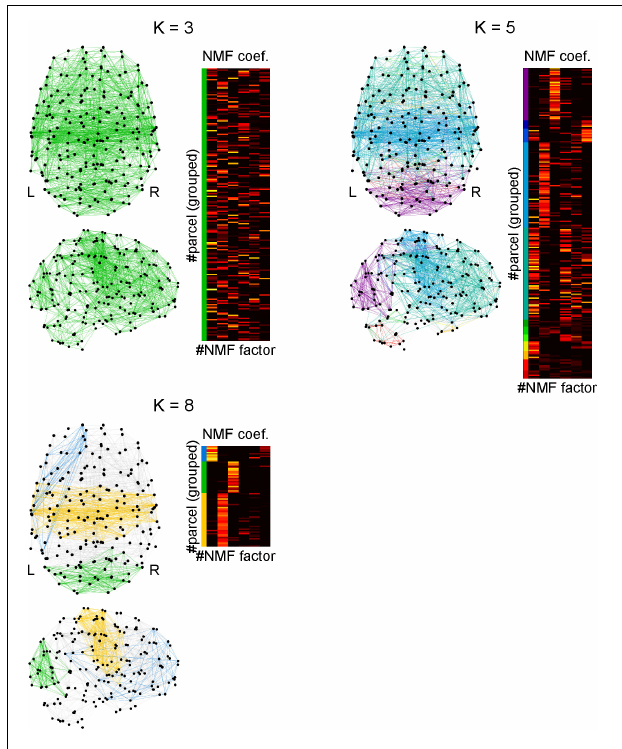
FIGURE 8 | Identifying densely connected subnetworks using clique percolation method. Subnetworks are color-coded and the non-negative matrix factorization coefficients of the parcels belonging to the subnetworks are shown in corresponding colors. The clique threshold K is a criterion for densities of connectivity in subnetworks to be identified. The connectivity becomes dense with an increase in K. When K = 3, all parcels were interconnected, which implies only one network was identified. When K = 5, 11 subnetworks were identified. When K = 8, three subnetworks were identified, in each of which the parcels were densely